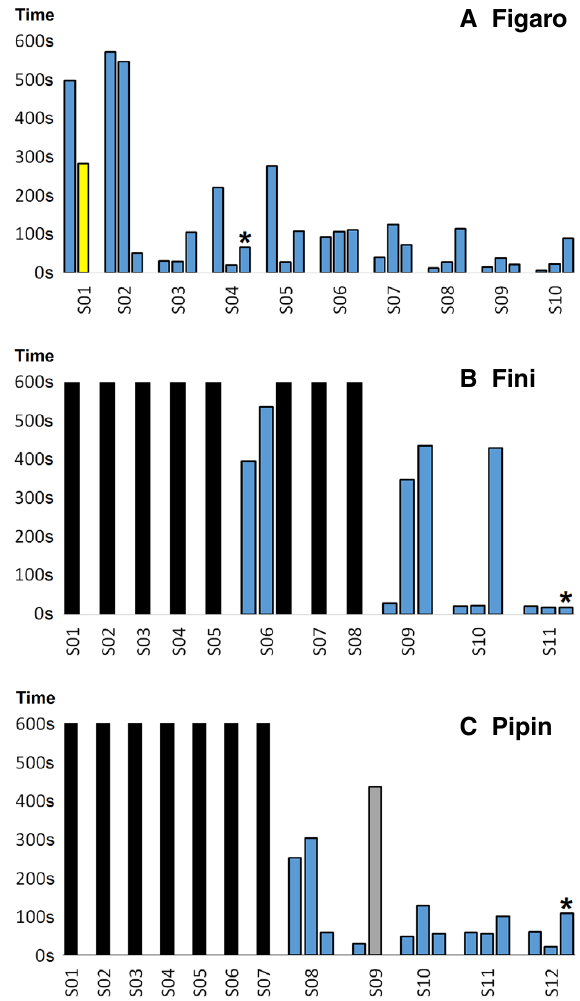
Figure 2. Progress until reaching criterion or completing the minimum number of sessions, for the 3 solvers: ( A ) Figaro, ( B ) Fini, and ( C ) Pipin. Colors: black (failed due to reaching the time limit), grey (failed due to inactivity), yellow (solved by cheating), and blue (solved). The asterisk marks the criterion point. Y axis, time (seconds); X axis, sessions and